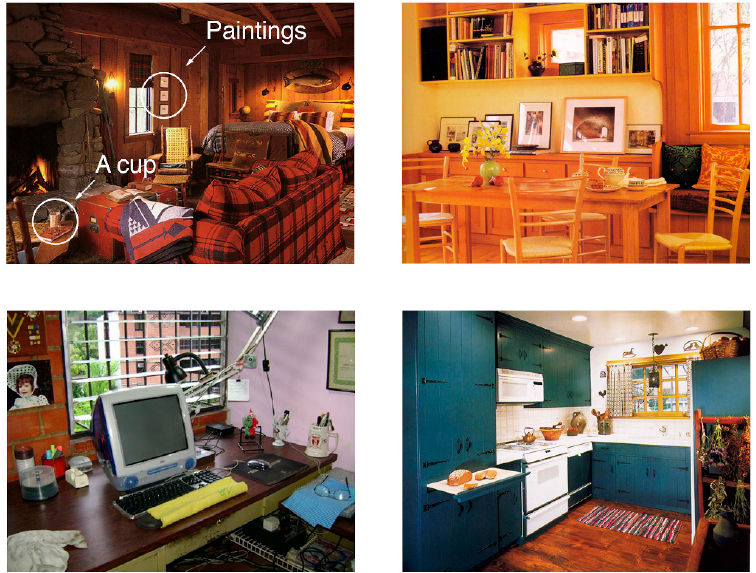
Figure 1. The examples of visual stimuli taken from the LabelMe database [31].